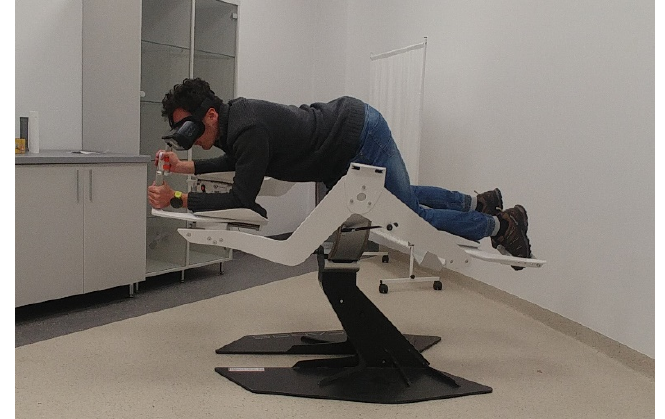
Figure 2. Icaros Pro – flight simulator in VR. Source: author’s elaboration.